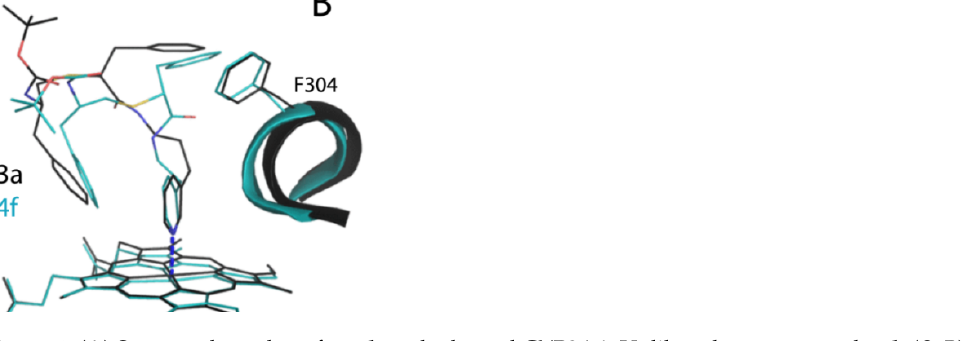
Figure 4. ( A ) Structural overlay of 3a – d - and 8 -bound CYP3A4. Unlike other compounds, 3b ( S , R ) has a less favourable reverse side-group orientation, with R 2 –phenyl above the I-helix (P1 site) and R 2 –phenyl near the heme-ligating pyridine (P2 site). The disordered end-moiety of 3b is not shown. ( B ) Comparison of isosteric 3a and series IV 4f analogue [10] demonstrates how one-atom linker elongation impacts the ligand binding mode. The Boc-group of 4f is disordered and shown in an arbitrary conformation. Table 2. Structural features of CYP3A4–inhibitor